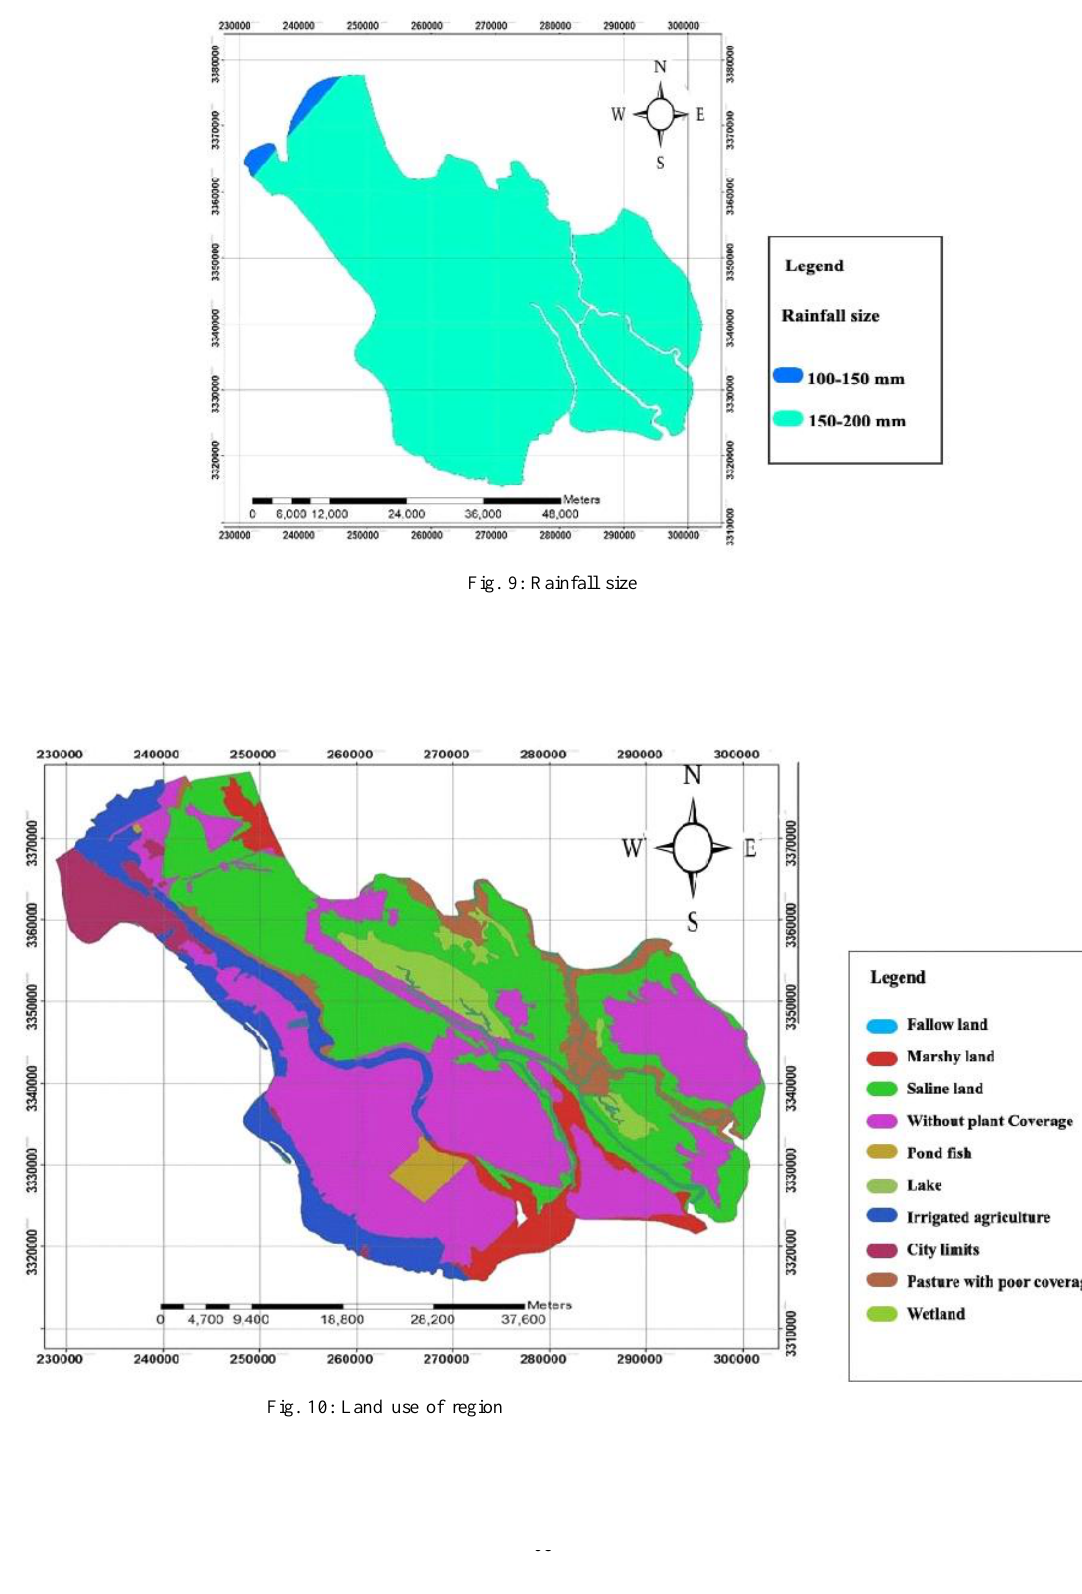
Fig. 10: Land use of